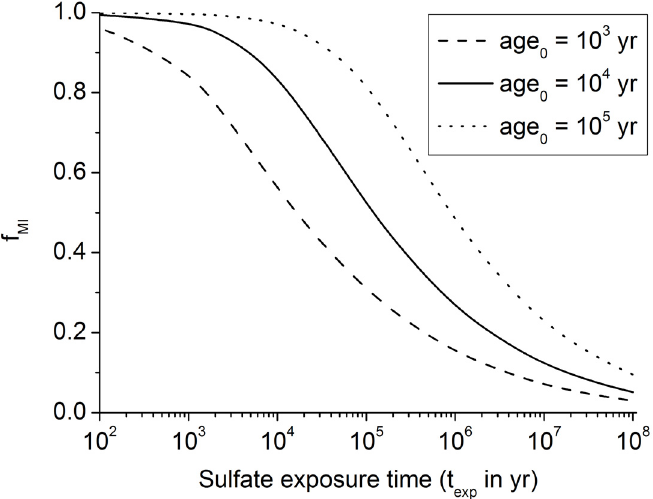
Figure 5. Fraction of buried POC entering the methanogenic zone ( f Equation (9) for initial ages of 1000 yrs, 10,000 yrs, and 100,000